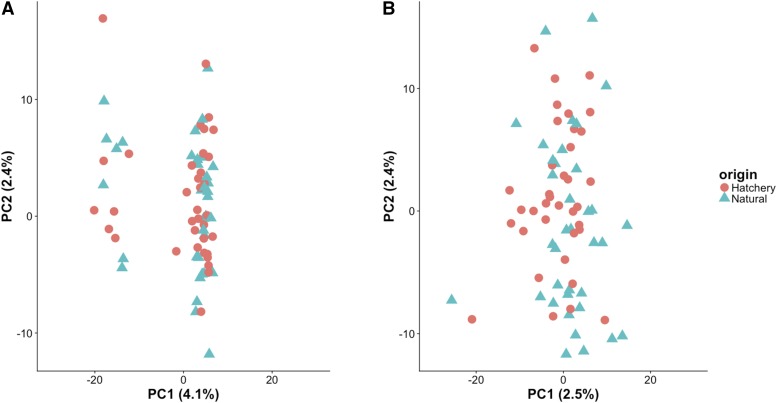
PCA ordination of RAD-Seq data. Individual hatchery and natural-origin fish are plotted according the first 2 principal components (PC1 and PC2) using 936 SNPs (A). The PCA was repeated after removing a group of markers in very high LD using 907 SNPs (B).